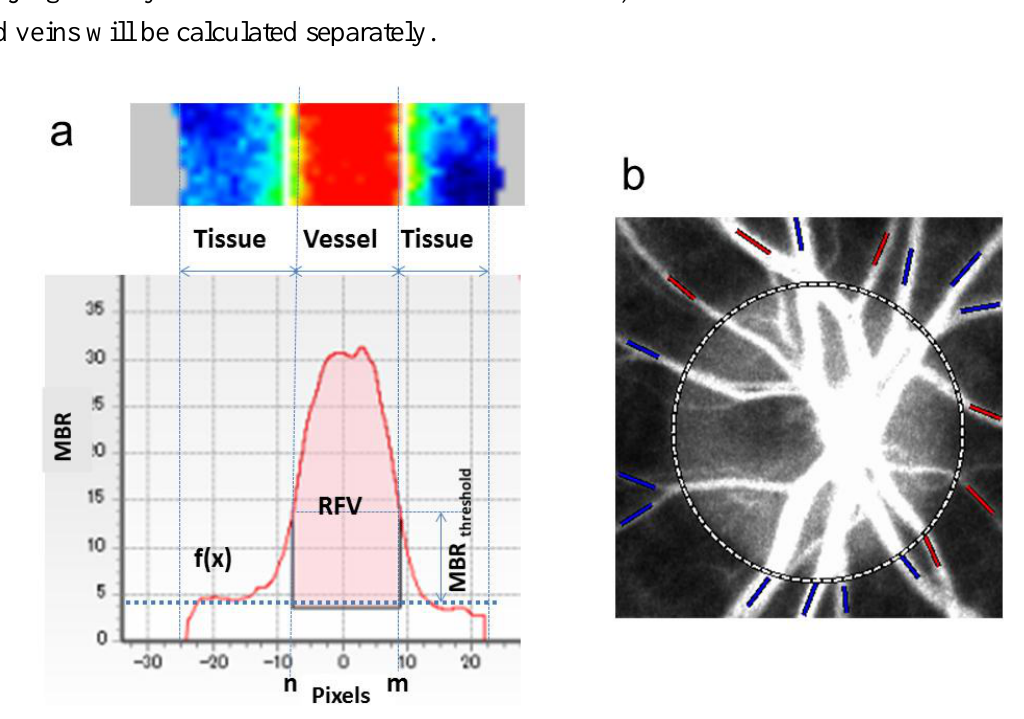
Figure 7. ( a ) Determination of Retinal flow volume (RFV). The MBR